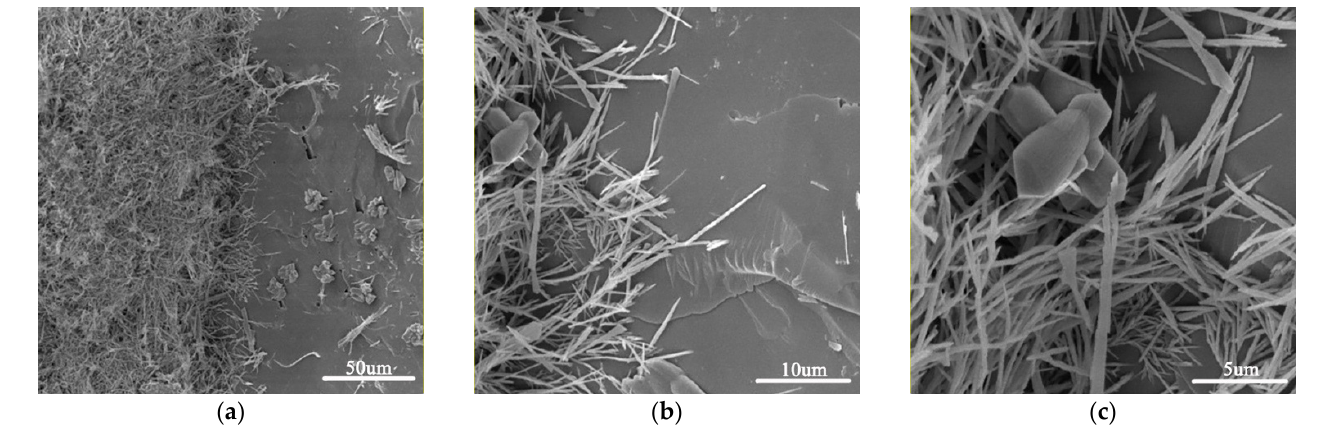
Figure 4. SEM images of an ITZ in sample MG4 ( a – c ) at different scales.